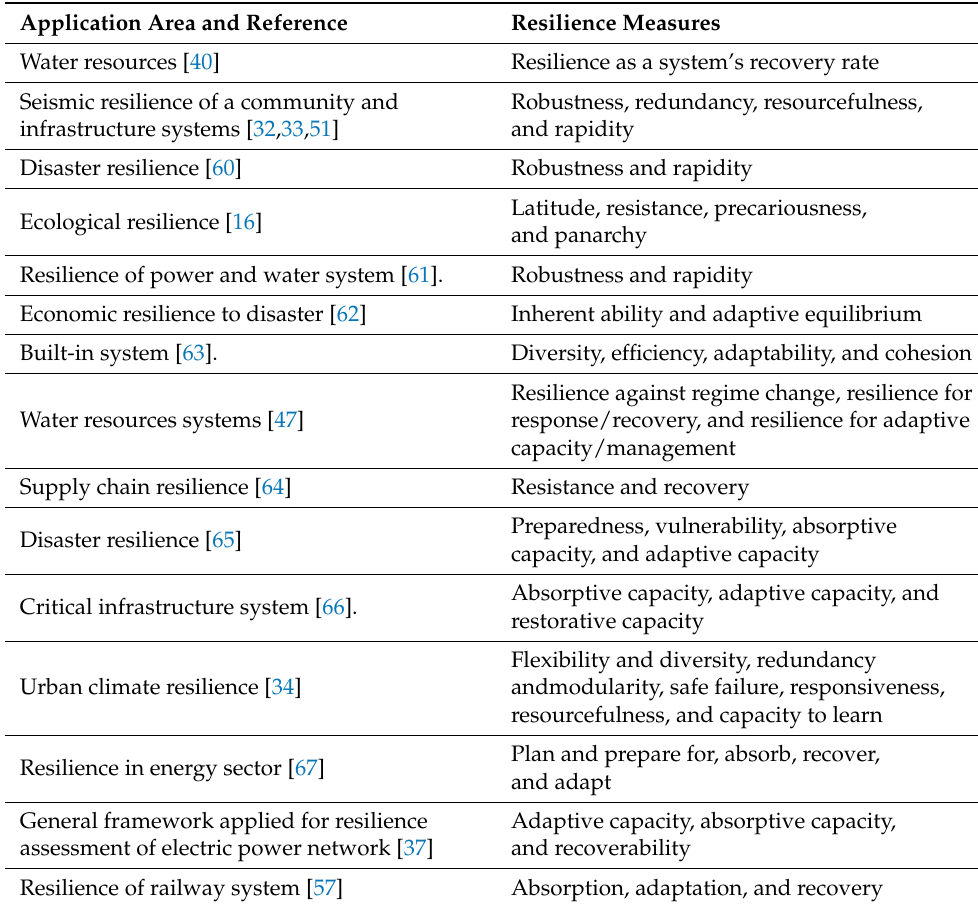
Table 2. Commonly used resilience measures in water and other